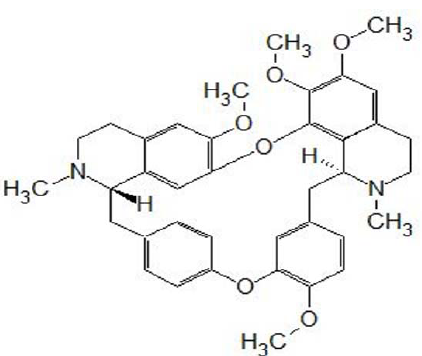
Figure 1. Stucture of